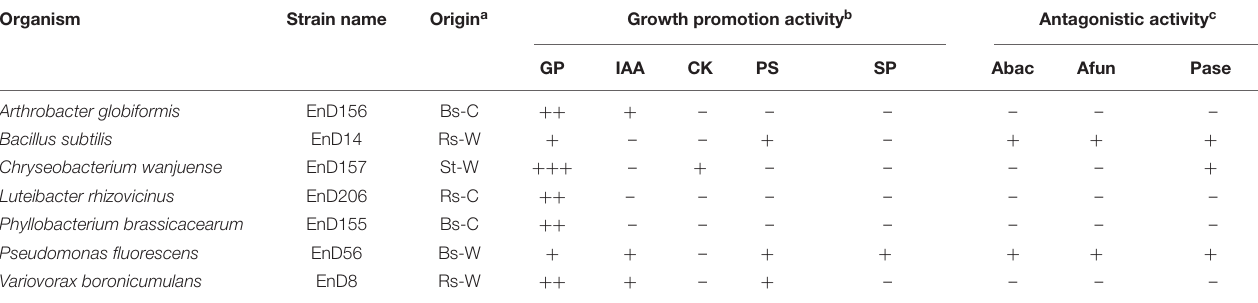
TABLE 1 | Plant growth promoting and antagonistic activities of bacteria selected from rhizosphere and roots of long-sepal Donggang pasque-flower plants. Organism